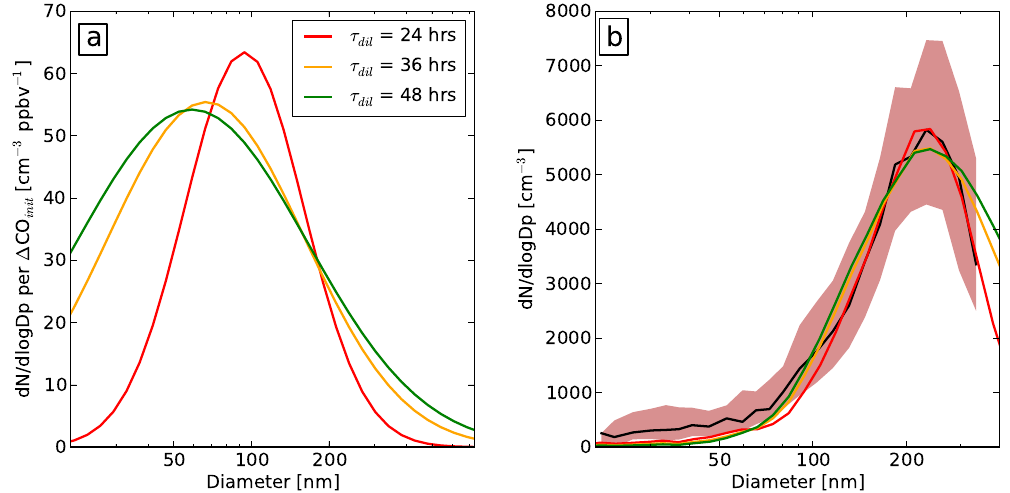
Figure 9. (a) shows the optimized young-plume size distributions for entrainment parameters τ dil = 24, 36, and 48h as particle concentration per (cid:49) COinit (cm − 3 ppbv − 1 ). (b) shows the final, modelled size distributions compared to the measured aged plume size distribution (black: median; red: